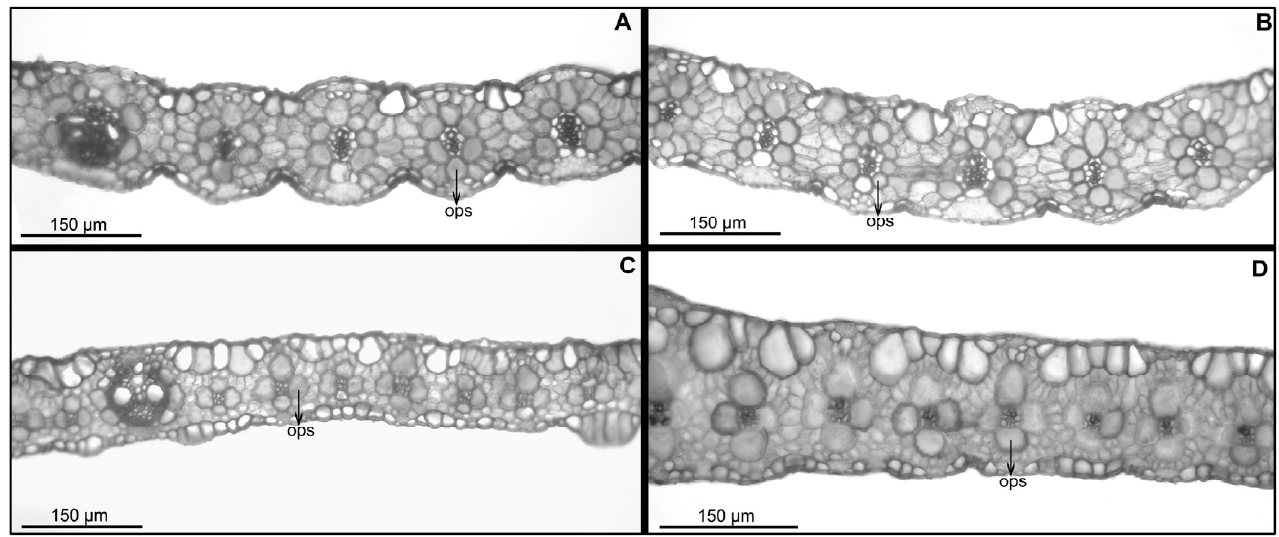
Figure 2. Light micrographs of leaf blade in cross section: ( A–B ). Panicum deustum ; ( C ). Panicum trichocladum ; ( D ). Panicum vollesenii . Abbreviations: ops = outer parenchymatous bundle [vouchers: ( A ): Bequaert 3398 , ( B ): de Witte 10792 , ( C ): Hitchcock 24927 , ( D ): Vollesen 3871 ].